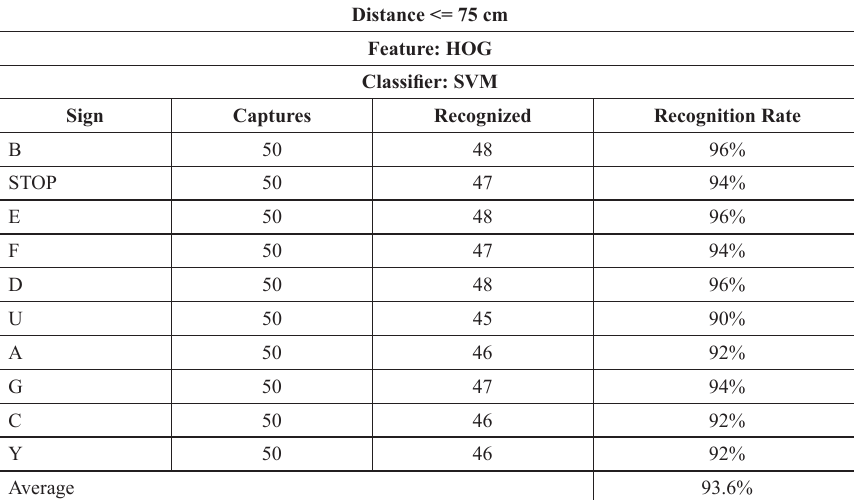
Table 2. Recognition rate of our